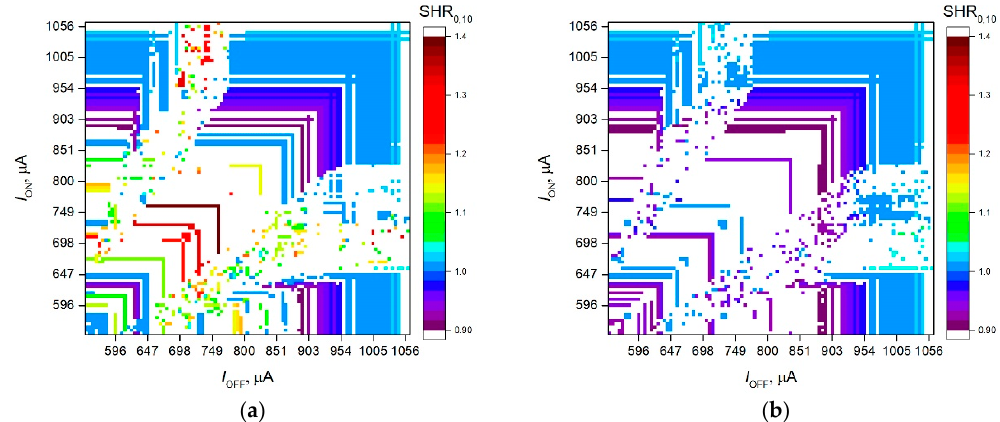
Figure 18. The synchronization distribution SHR 0,10 in the regions of currents I ON and I OFF with ( a ) s o = 0.29V and ( b ) s o = 0.1 V. For all cases, I 0 = 1017 µA, I 10 = 891 µA, s r = 0.1036 V, s m = 0.207 V, η th = 90%, U n = 80 µV, and the class C 94 is on the input.